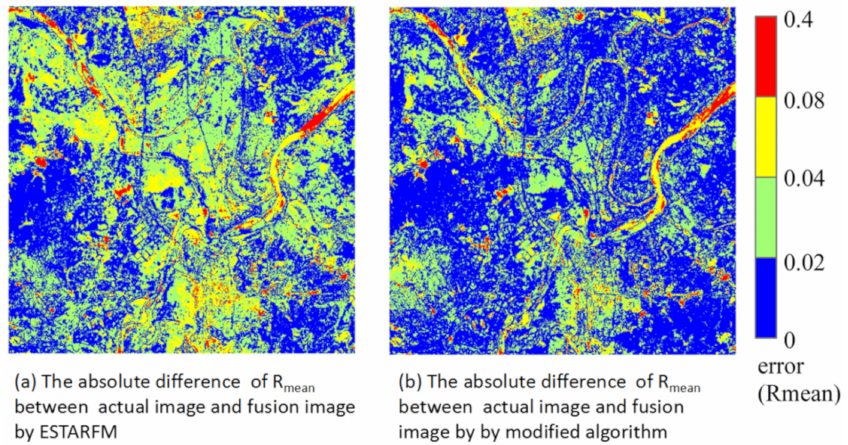
Figure 7. The comparison of the absolute di ff erence of R mean between the true observed image and predicted image by ESTARFM ( a ) and the modified algorithm ( b ).